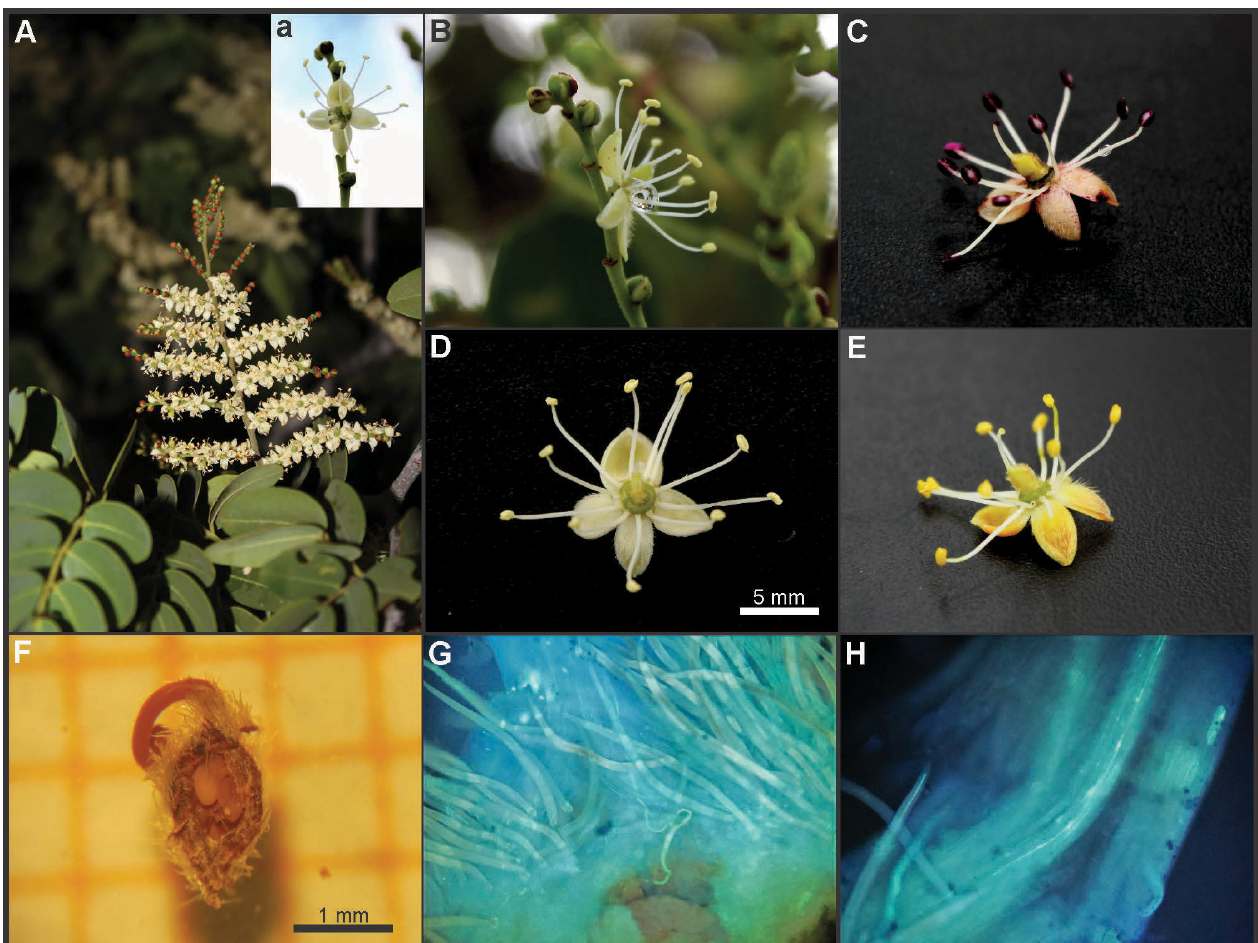
Figure 2 – Copaifera coriacea . A . Inflorescence and flower (inset a), emphasizing the orientation of the floral axis, in frontal view and in lateral view. B . Accumulated nectar droplets. C . Presence of osmophores. D . Detail of the flower in frontal view, showing the four sepals, stamens, green nectary, and pistil at the centre. E . Pigments that reflect ultraviolet light. F . Ovary in longitudinal section, with two marginally attached ovules. G–H . Results of the epifluorescence microscopy of the pollination treatments mediated by bees, focusing pollen tubes penetrating into the ovule ( G ), and pollen tubes in the canal stylar ( H